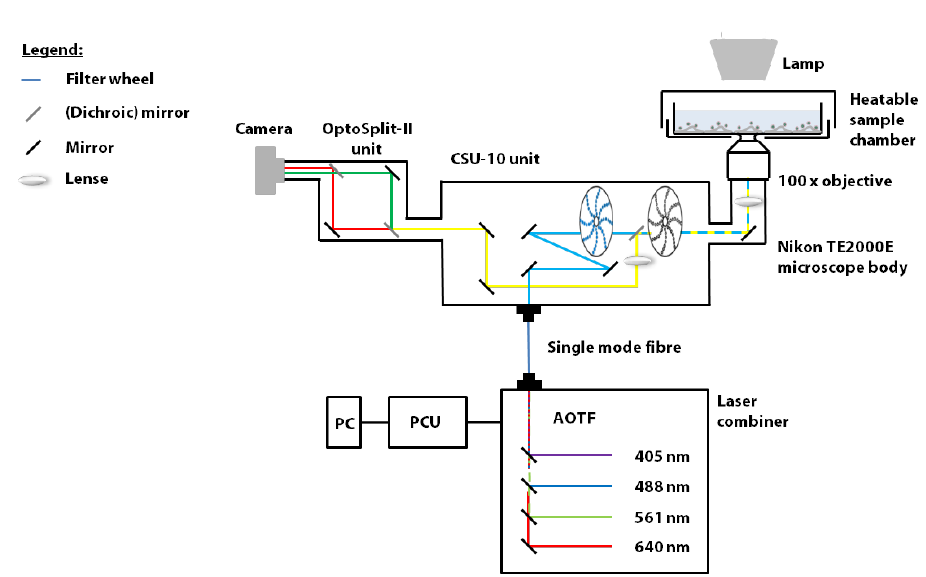
Figure A1. Spinning disk confocal microscope setup. A modified confocal spinning disk setup based on an Andor Revolution system was used. Continues wave laser lines of 405 nm, 488 nm, 561 nm and 640 nm wavelength built into the Andor Laser Combiner were directed into a single mode fiber. Continues wave laser lines of 445 nm, 514 nm, 594 nm and 685 nm were combined with the appropriate dichroic mirrors and directed into a single mode fiber together with the other laser lines and all laser lines were coupled into a Yokogawa CSU-10 unit and focused onto the sample by a 100×, 1.49 NA objective. The fluorescence signal was split with the appropriate dichroics and focused onto 3 Andor iXon cameras equipped with the appropriate emission filters. A piezo element inserted into the stage enabled the recording of z -stacks and a heatable sample chamber allowed live cell measurements at 37 °C. A perfect focus system was used to compensate for z -drift during data acquisition.